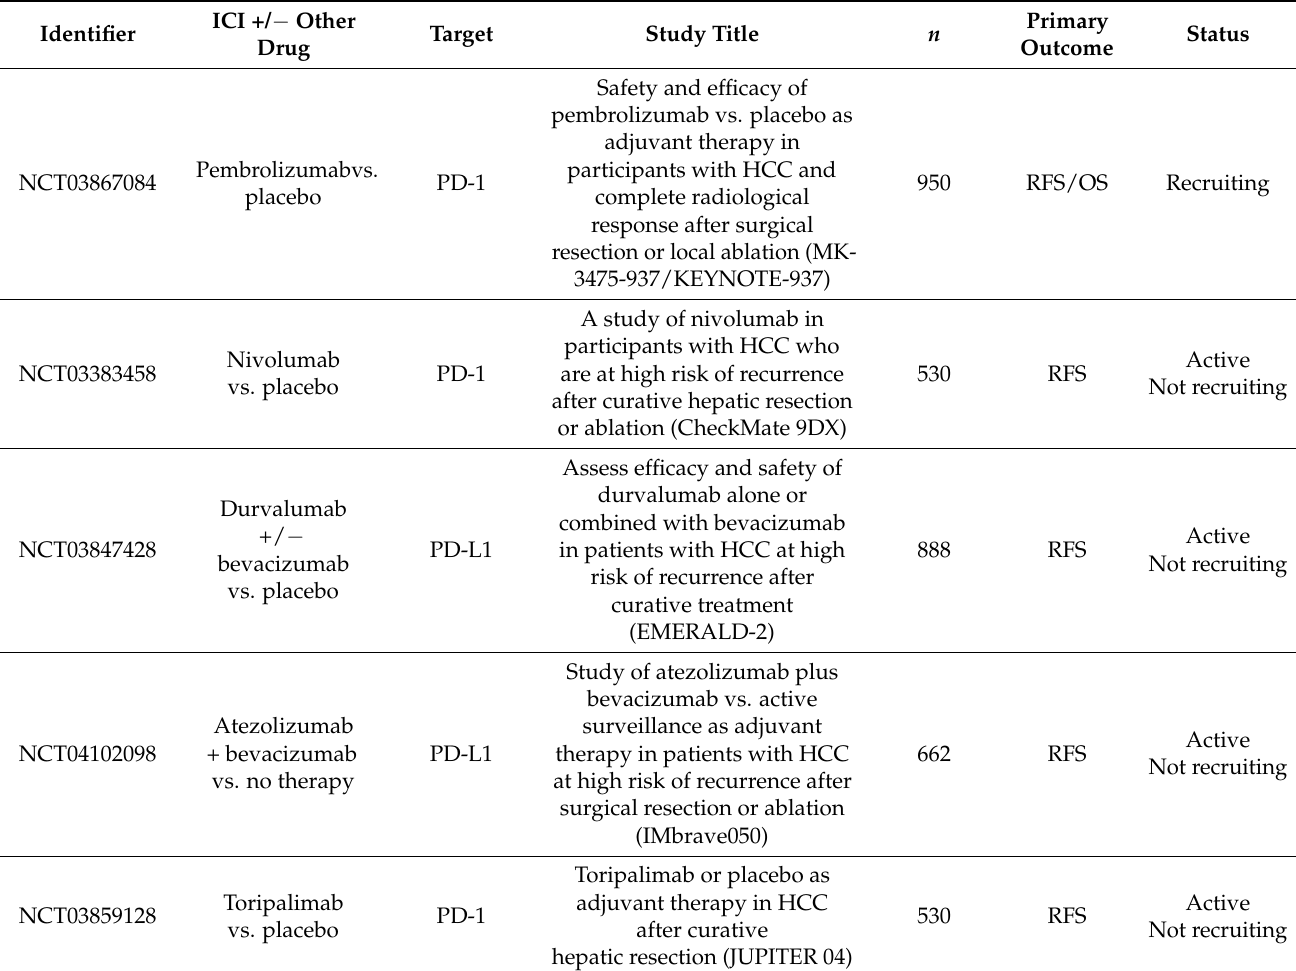
Table 4. Phase III trials evaluating immunotherapy as adjuvant therapy after surgery or local ablation for localized hepatocellular